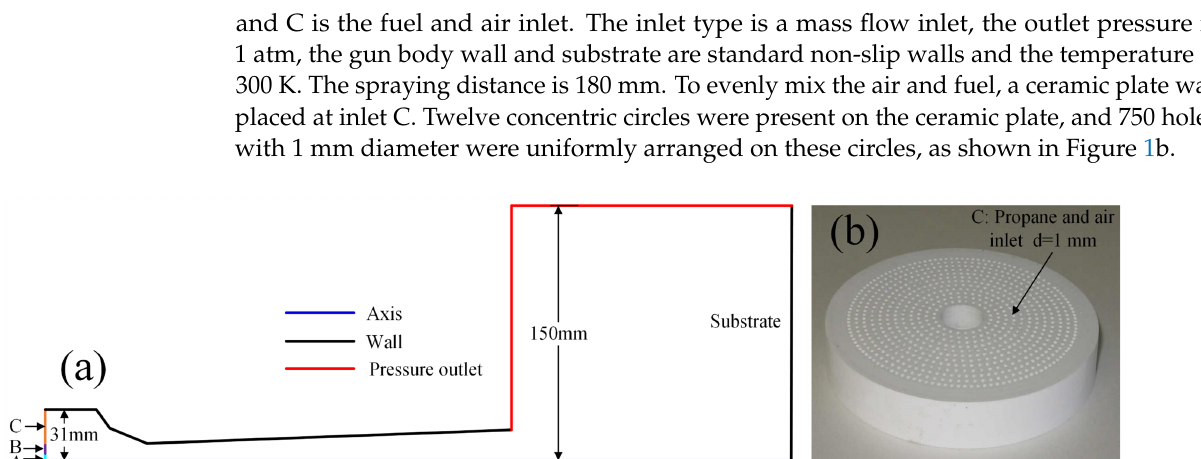
Figure 1. AK07 spray gun: ( a ) schematic diagram and boundary conditions and ( b ) ceramic plate.